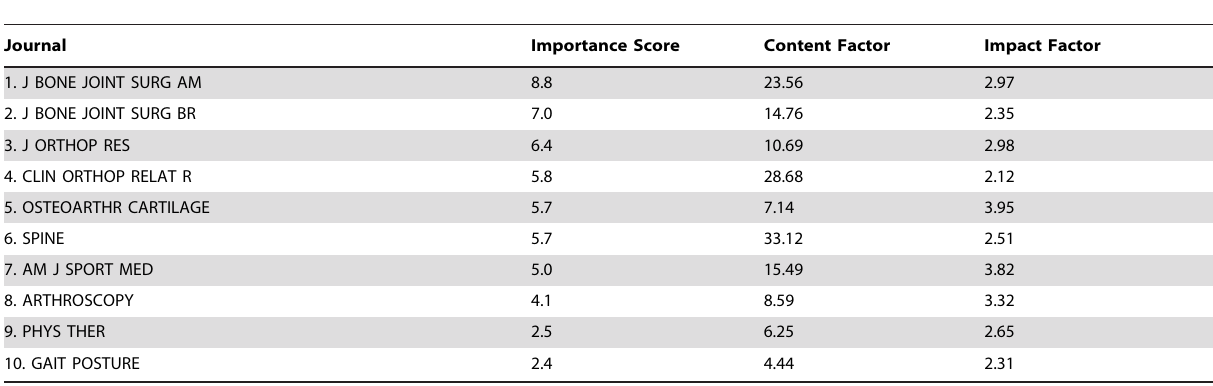
Table 3. Importance Scores Assigned by the OKU Authors to a Sample of 10 Orthopaedic Surgery Journals, along with their Content and Impact